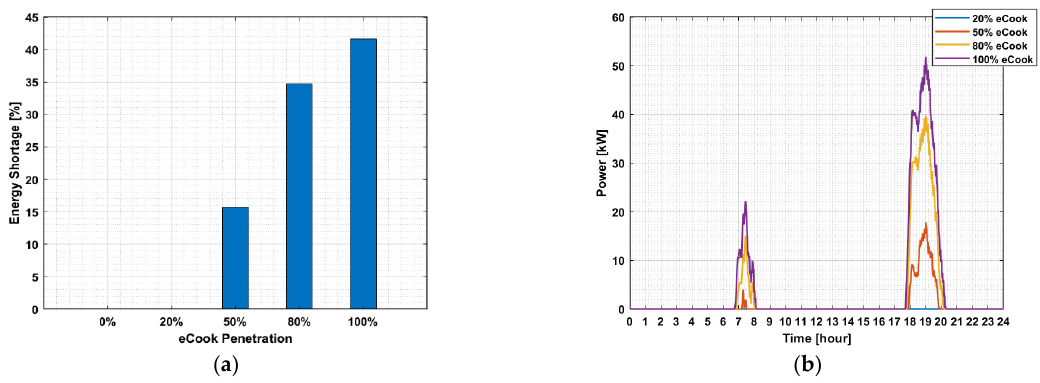
Figure 8. ( a ) Energy shortage for a weekday in April; ( b ) Power not met for a weekday in April.